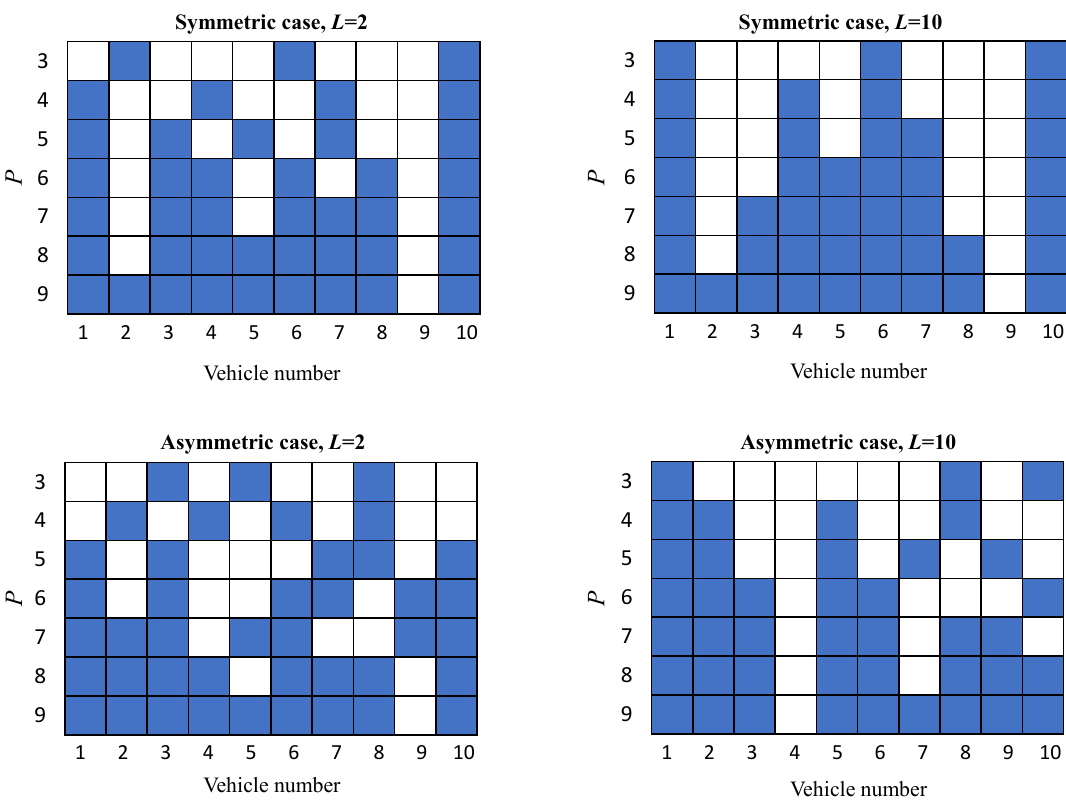
Figure 4. Optimal patterns of vehicles’ positions with available REM values that achieve the minimum MSE of REM reconstruction for different values of P in a platoon with N =